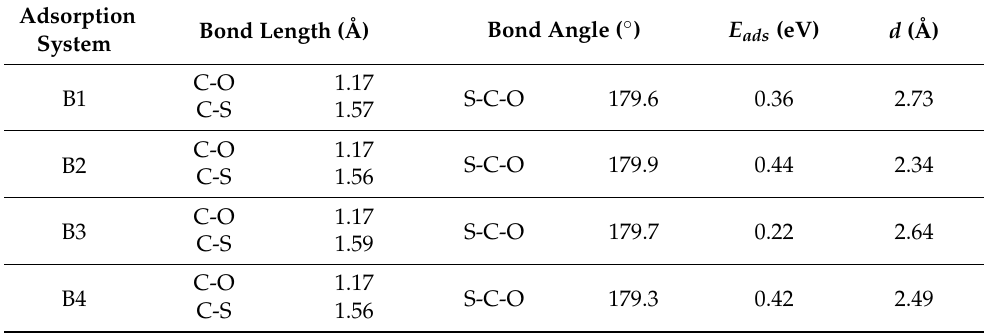
Figure 8. The stable adsorption configurations B1 and B2 of COS molecules on a pure α -Fe 2 O 3 (001) surface; the stable adsorption configurations B3 and B4 of COS molecules on the vacancy α -Fe 2 O 3 (001) surface (the unit of number is Å). Table 3. The adsorption energy and adsorption configuration characteristic parameters of COS on the α -Fe 2 O 3 (001) surface.